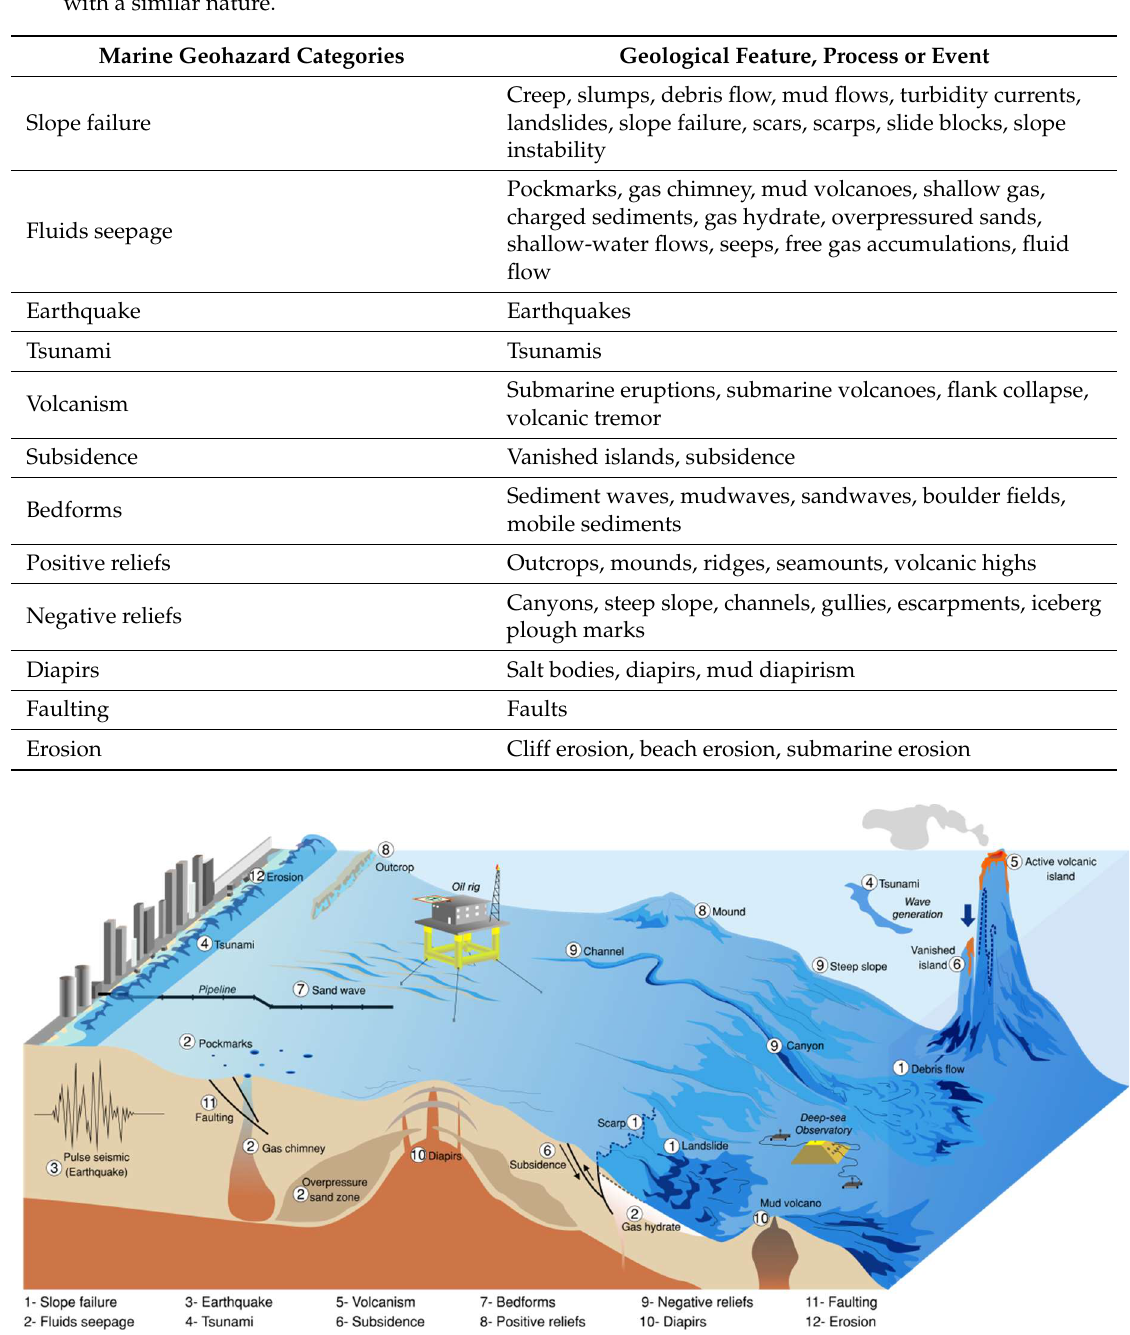
Table 1. Categories of geohazards defined after the grouping of features, process, and related events with a similar nature.